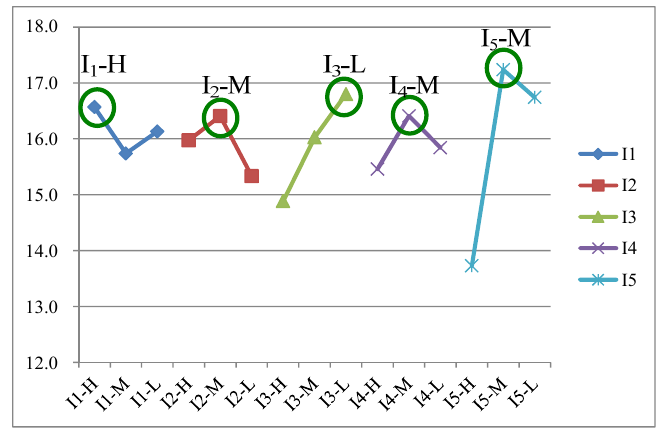
Figure 8. Response graph for the S / N ratio.